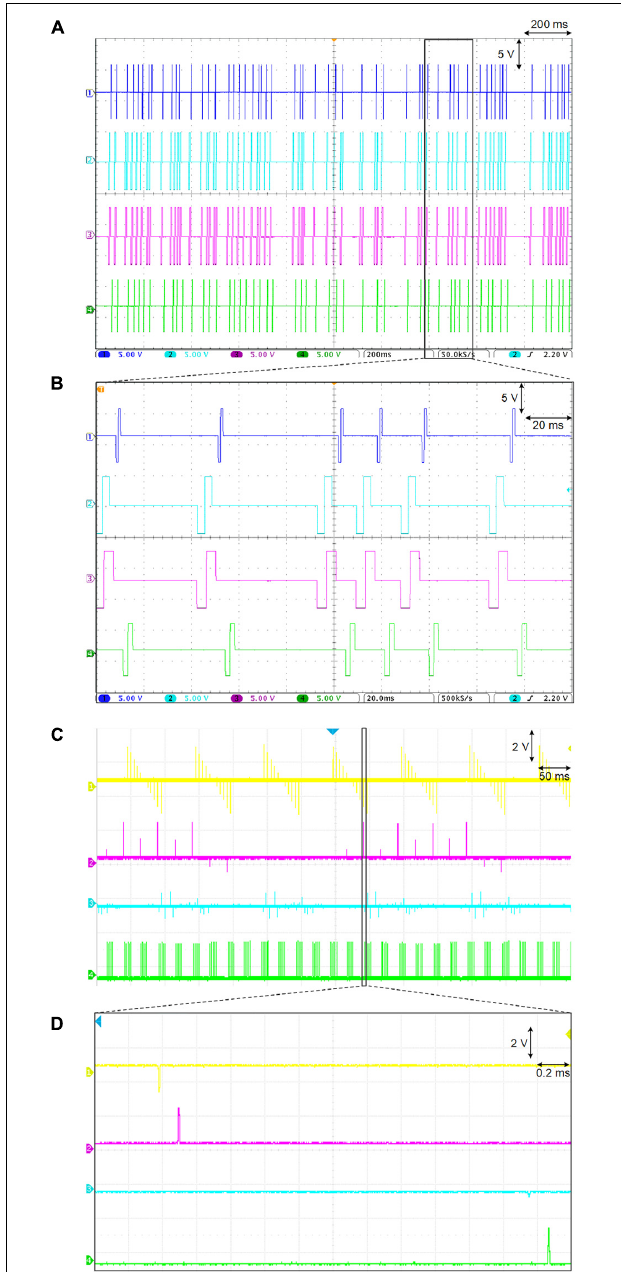
FIGURE 11 | Bench-top test results demonstrate a variety of pulse trains protocols. (A) Multi-channel stimulation with random inter-pulse-interval, which follows an exponential distribution. (B) Magnified view of panel (A) shows the different pulse widths and start delays among different channels. (C) Multi-channel stimulation with independent control of waveform, frequency, amplitude and pulse timing. (D) Magnified view of panel (C) .